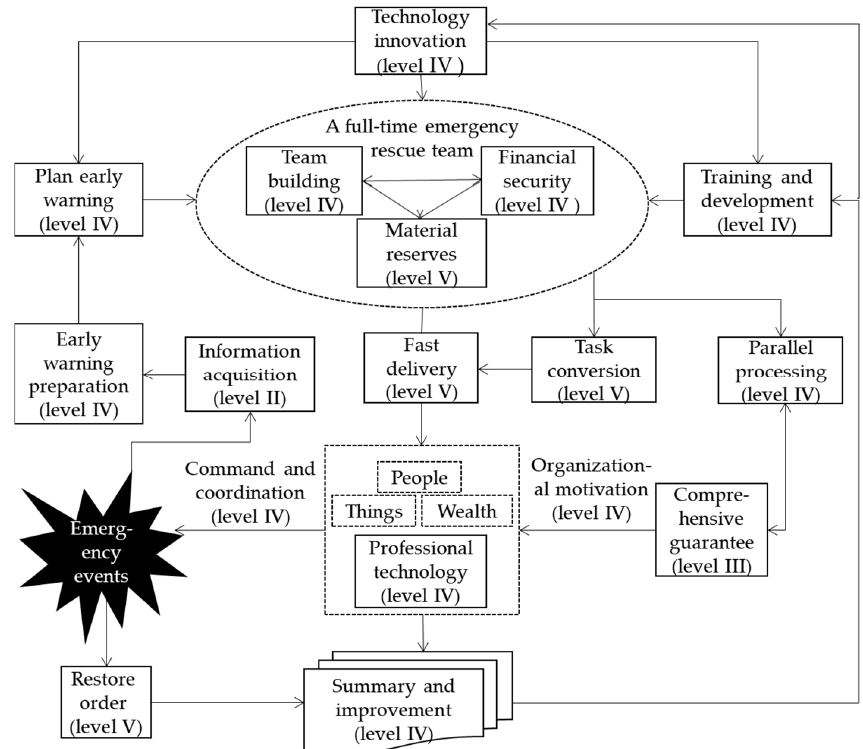
Figure 3. Spiral organizational competency model of the full-time water conservancy emergency rescue team in Province A.